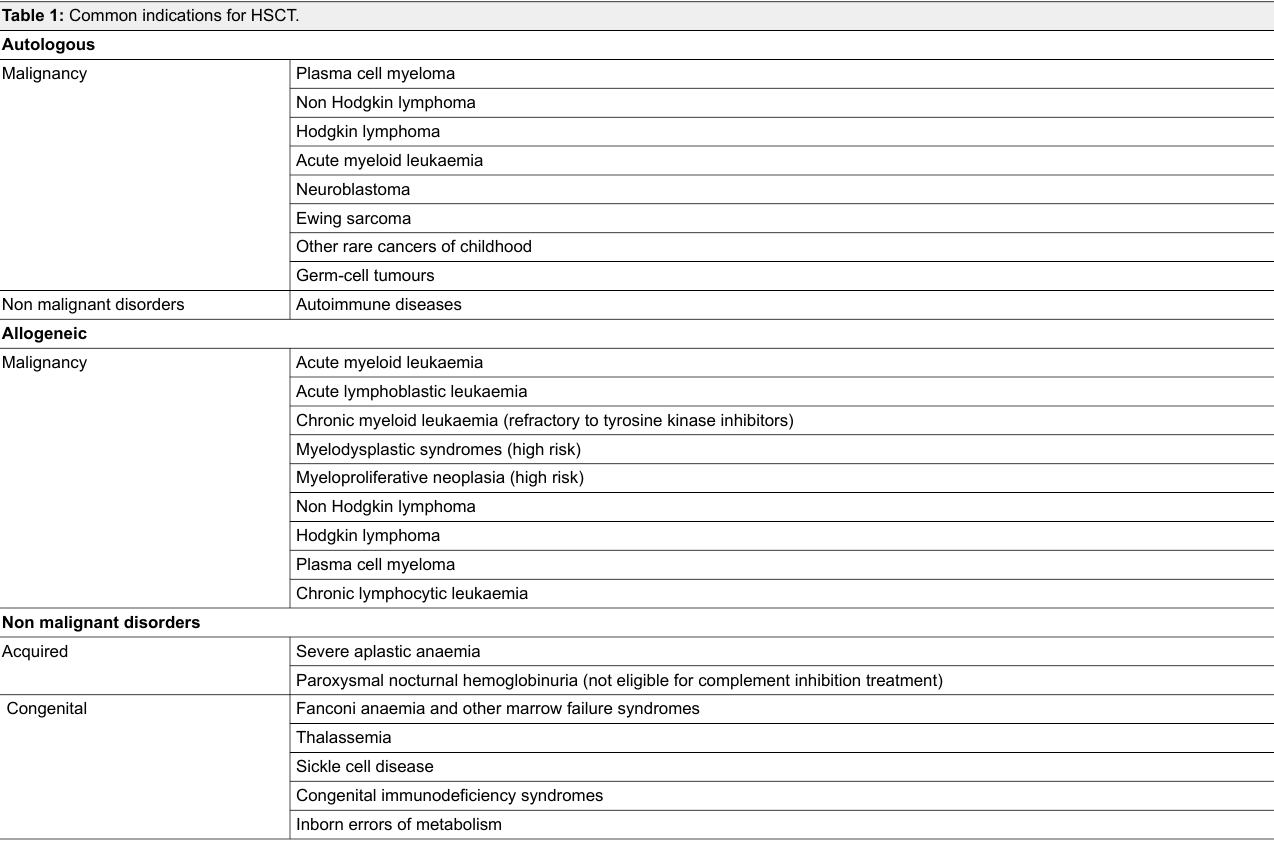
Table 1: Common indications for HSCT.